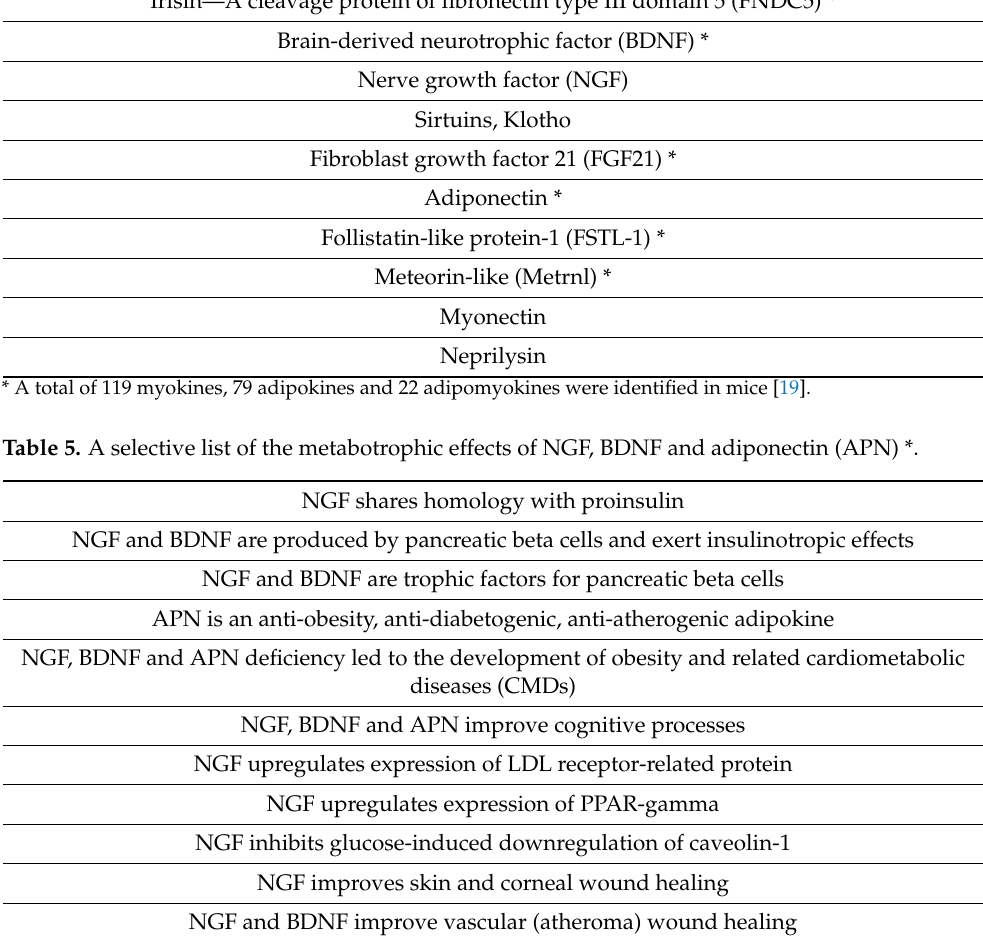
Table 4. A selected list of adipokines and myokines, some being adipomyokines *.